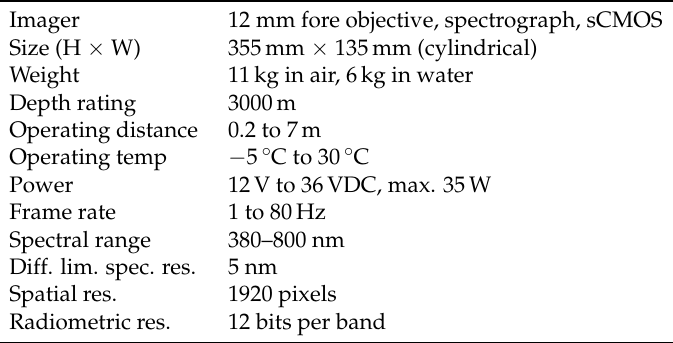
Table 1. Ecotone UHI-3